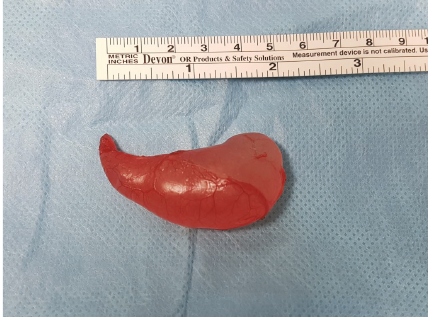
Figure 2: The cyst, once